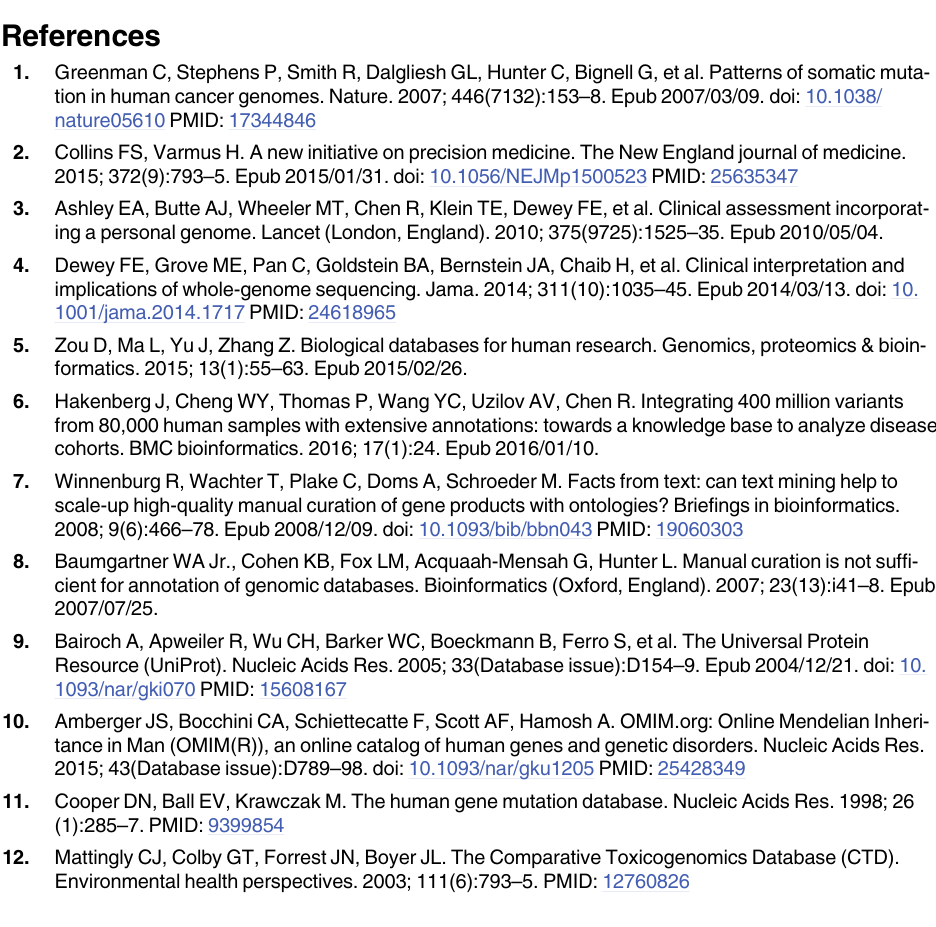
S1 Fig. Disease-wise analysis of disease-gene variant accuracy. (TIF) S1 Data. File with raw results.